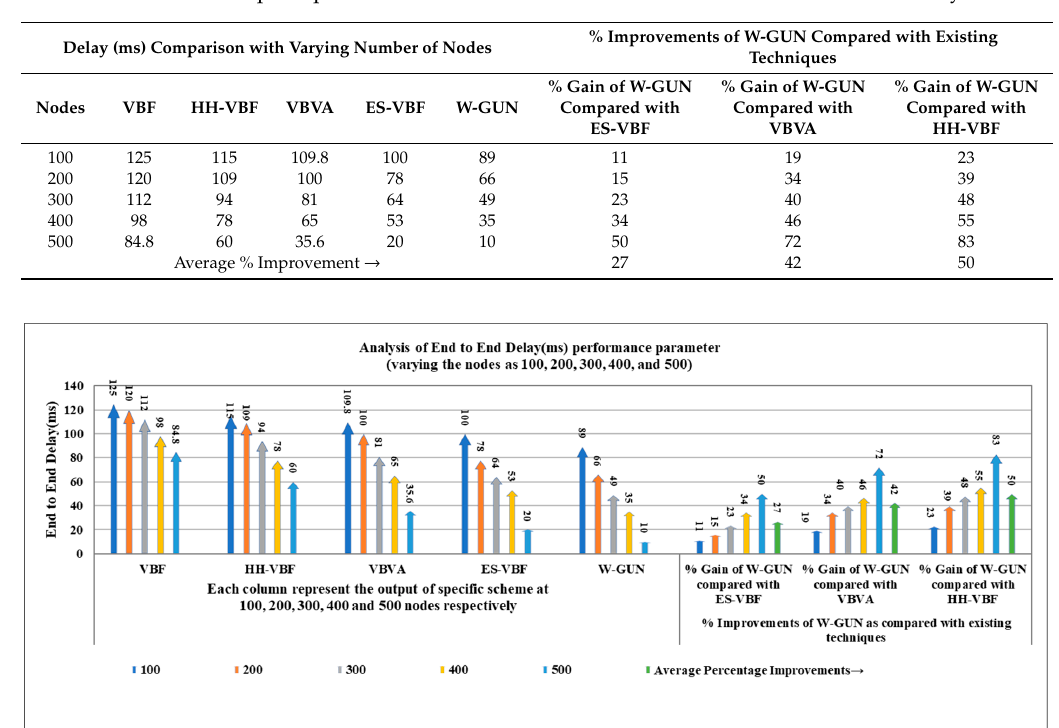
Figure 4. Detailed percentage-centric performance gain of W-GUN focusing on end-to-end delay .